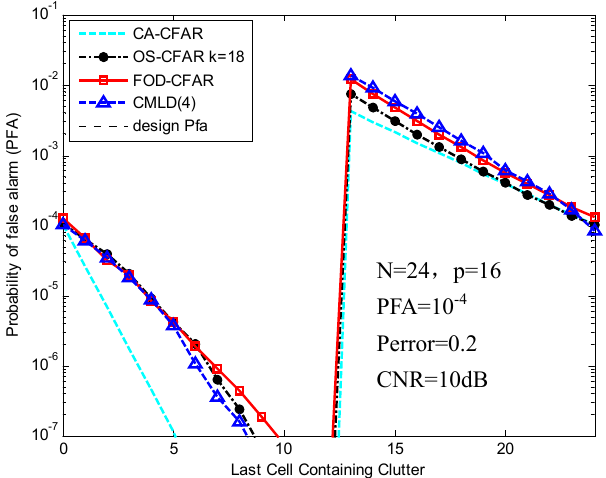
Figure 12. PFA comparison of FOD-CFAR, OS-CFAR, CA-CFAR and CMLD(4) in the clutter edge